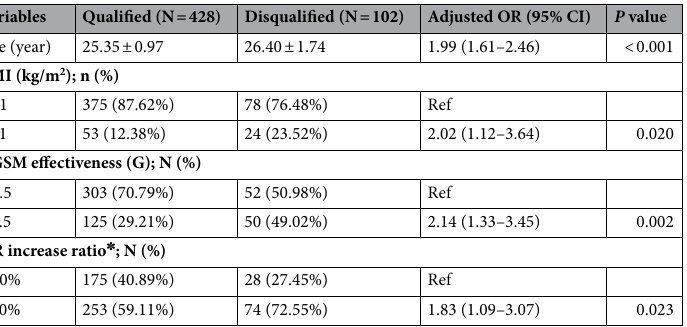
Table 4. Multivariate analysis of 9G profile training tolerance performed with logistic regression. N number, BMI body mass index, AGSM anti-G straining manoeuvre, HR heart rate, OR odds ratio, CI confidence interval. *Maximal HR during the initial 1–5 s of the 9G profile divided by HR before the 9G profile.